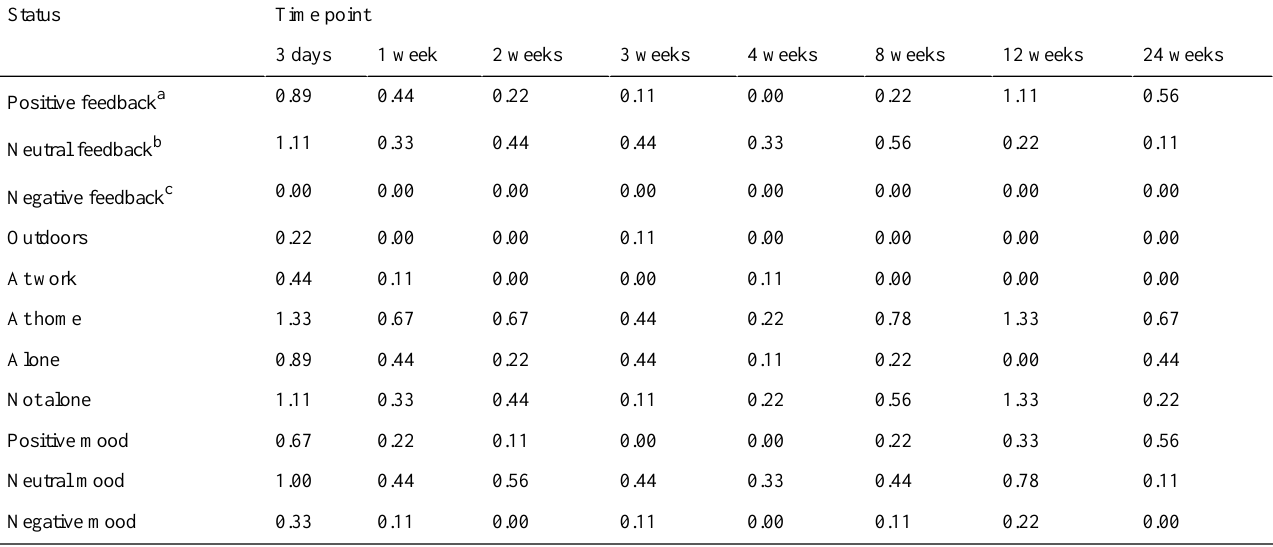
Table 4. Average frequencies of situation status and relapse reporting of app users at every measurement time point during follow-up. Time